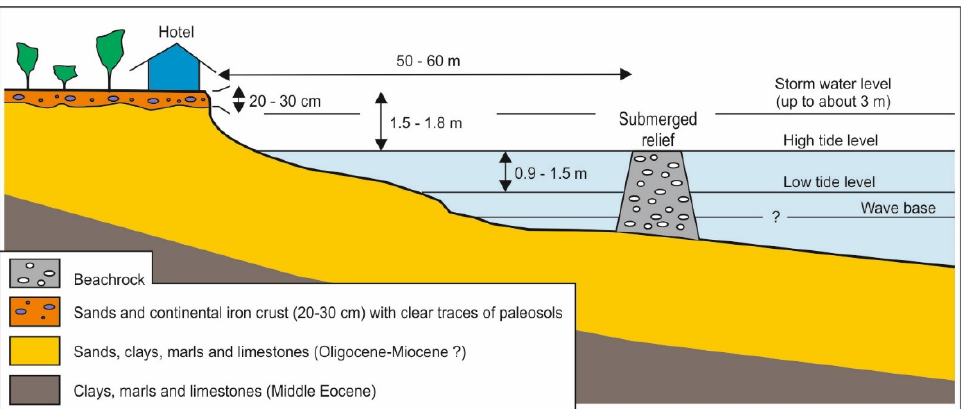
Figure 8. Geological and Geomorphological section across a sector of the beach of Lomè to the east of the port. The tidal excursion (observations carried out in December 2016 and December 2019) causes the emergence and submersion of the relief. The indicated value of storm water level is indicative.